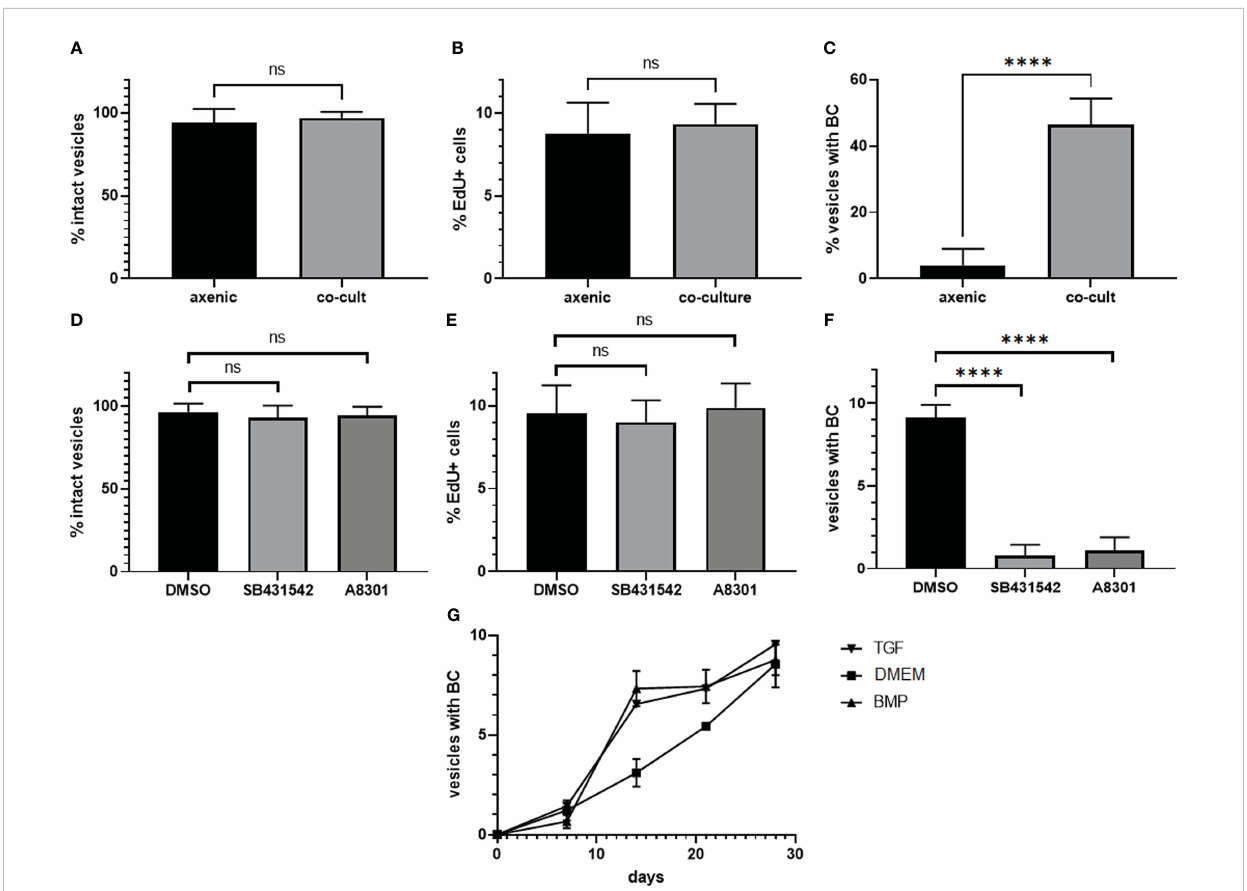
FIGURE 6 In fl uence of culture conditions and TGF b receptor inhibitors on BC formation. Upper panel: In fl uence of axenic cultivation (axenic) and co-culture with host feeder cells (co-cult) on vesicle survival (A) ), stem cell proliferation (B) , and BC formation (C) in metacestode vesicles of isolate MB17. Vesicles were grown in vitro under culture conditions as indicated for 3 weeks. Vesicle integrity (A) was measured light microscopically, stem cell proliferation (B) by EdU incorporation (in % EdU+ cells of all cells), and BC formation by light microscopy (visible BC). DMSO indicates control. Statistical analysis: unpaired t-test in GraphPad Prism. ns, not signi fi cant, ****p < 0.0001. Middle panel: In fl uence of TGF b receptor inhibitors on metacestode vesicle survival (D) , stem cell proliferation (E) , and BC formation (F) . Metacestode vesicles of isolate MB17 were grown in vitro in co- culture in the presence of 10 µM of SB431542 and A8301 (as indicated) with medium changes every 3 - 4 days. Vesicle integrity, stem cell proliferation, and BC formation was assessed as in A – (C) DMSO indicates control. Statistical analysis: one-way ANOVA in GraphPad Prism. ns = not signi fi cant, ****p < 0.0001. (G) BC formation in vesicles in the presence of TGF b /BMP cytokines. Vesicles of isolate MB17 were in vitro cultivated in the co-culture system for 28 days in the presence of 1 nM of recombinant human TGF b (TGF) or BMP2 (BMP) with medium changes every 3 – 4 days. BC formation was assessed light microscopically. DMEM medium was used as a control. Shown are median with standard deviation. Unpaired t-test as assessed by GraphPad prism showed **** (p < 0.0001) at day 14 between TGF b and the control as well as between BMP2 and the